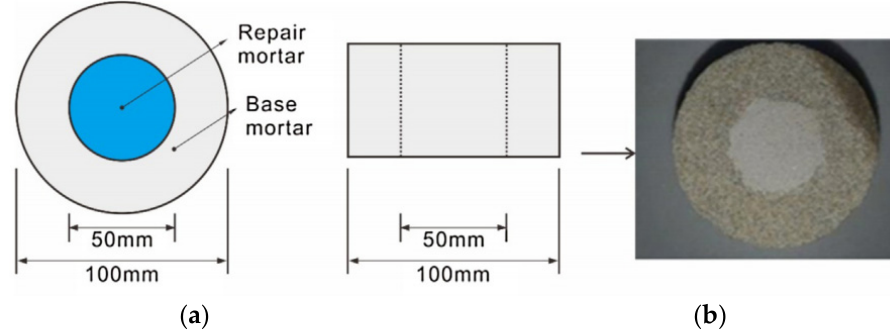
Figure 13. Test specimen details ( a ) top view, ( b ) side view [39].